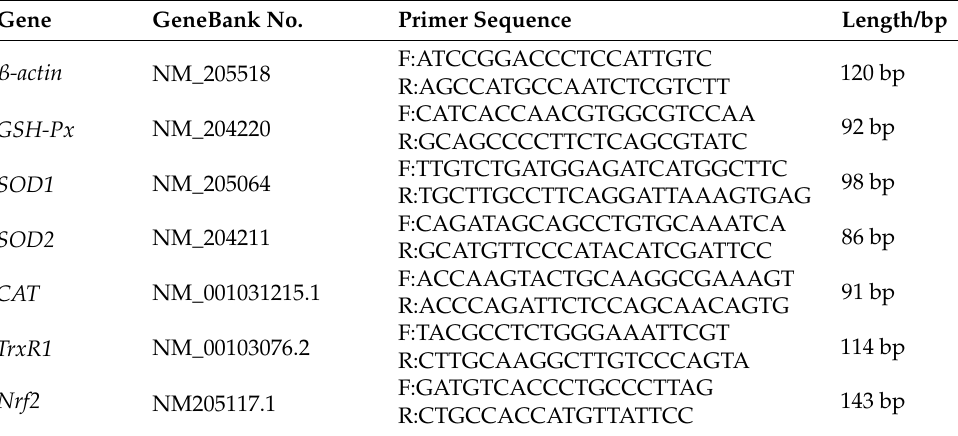
Table 2. Sequence of the object